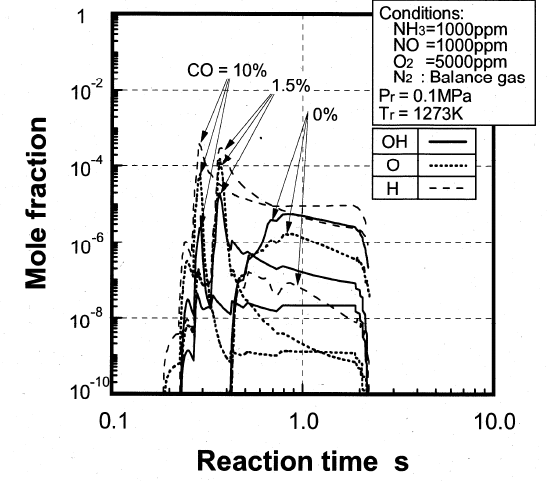
Figure 34. Mole fraction-time profiles of OH, O, H radicals, comparing CO = 0%, 1.5% and 10%, added in the NH temperature is 1273